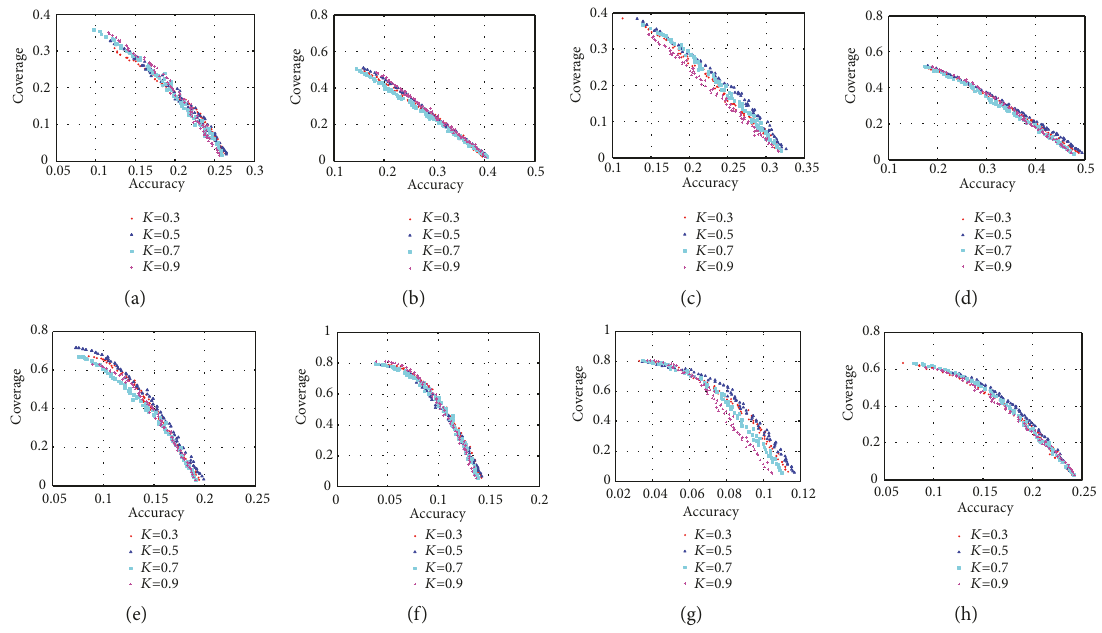
Figure 12: Influence of similar ratio parameter K to MOEA-EPG under the accuracy-coveragespace for (a) Movielens 1, (b) Movielens 2, (c) Movielens 3, (d) Movielens 4, (e) Netflix 1, (f) Netflix 2, (g) Netflix 3, and (h) Netflix 4. Table 8: Computational complexities of all comparison recommendation algorithms. Comparison algorithms